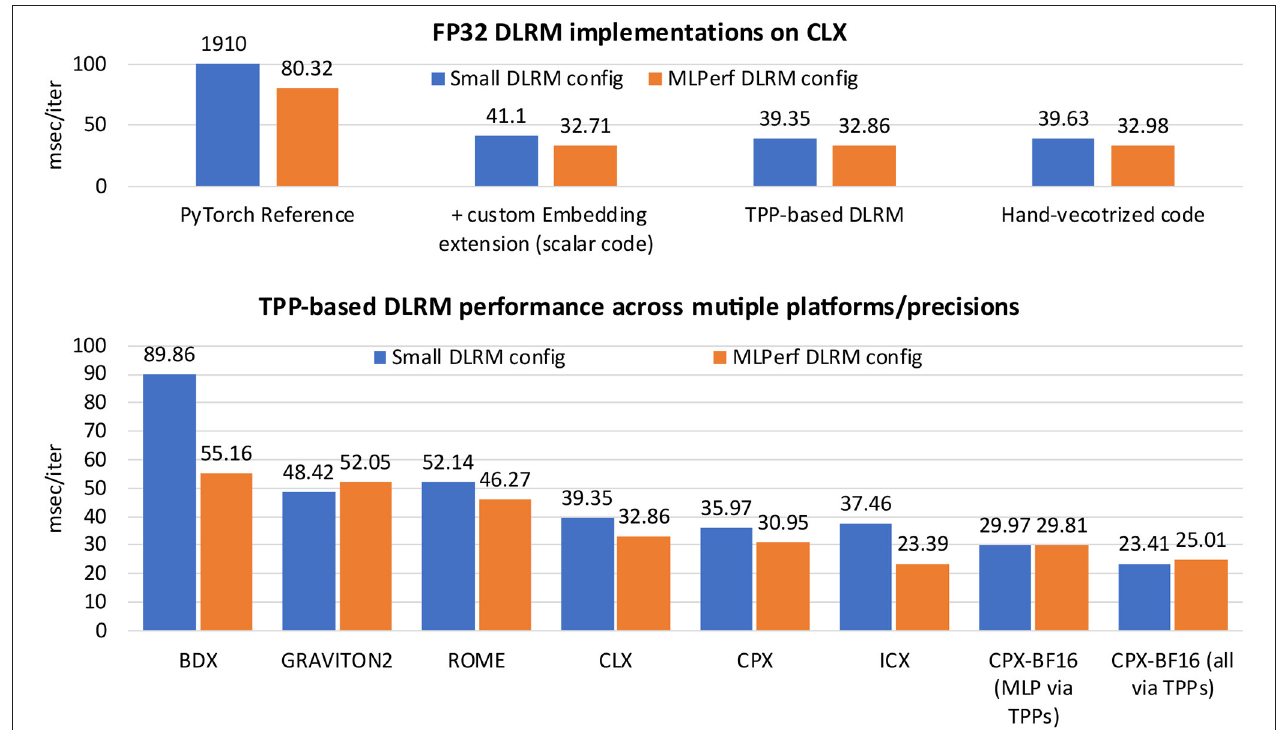
FIGURE 23 | DLRM performance on a small config (blue bars) and on the MLPerf config (orange bars).